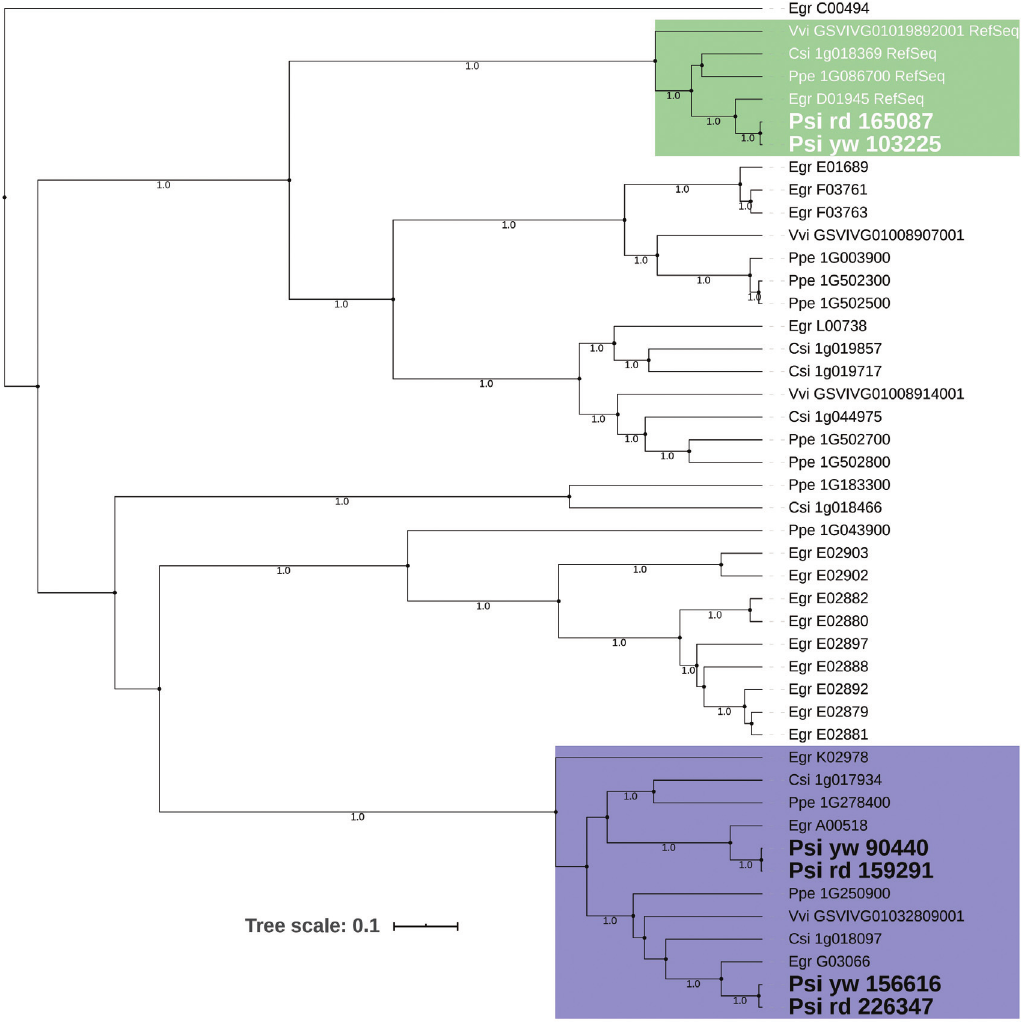
Figure 7 - Phylogenetic analysis showing the principal putative homologs of ANS of P. cattleyanum grouped with the reference sequence of other spe- cies. The posterior probabilities greater than 0.95 are shown on